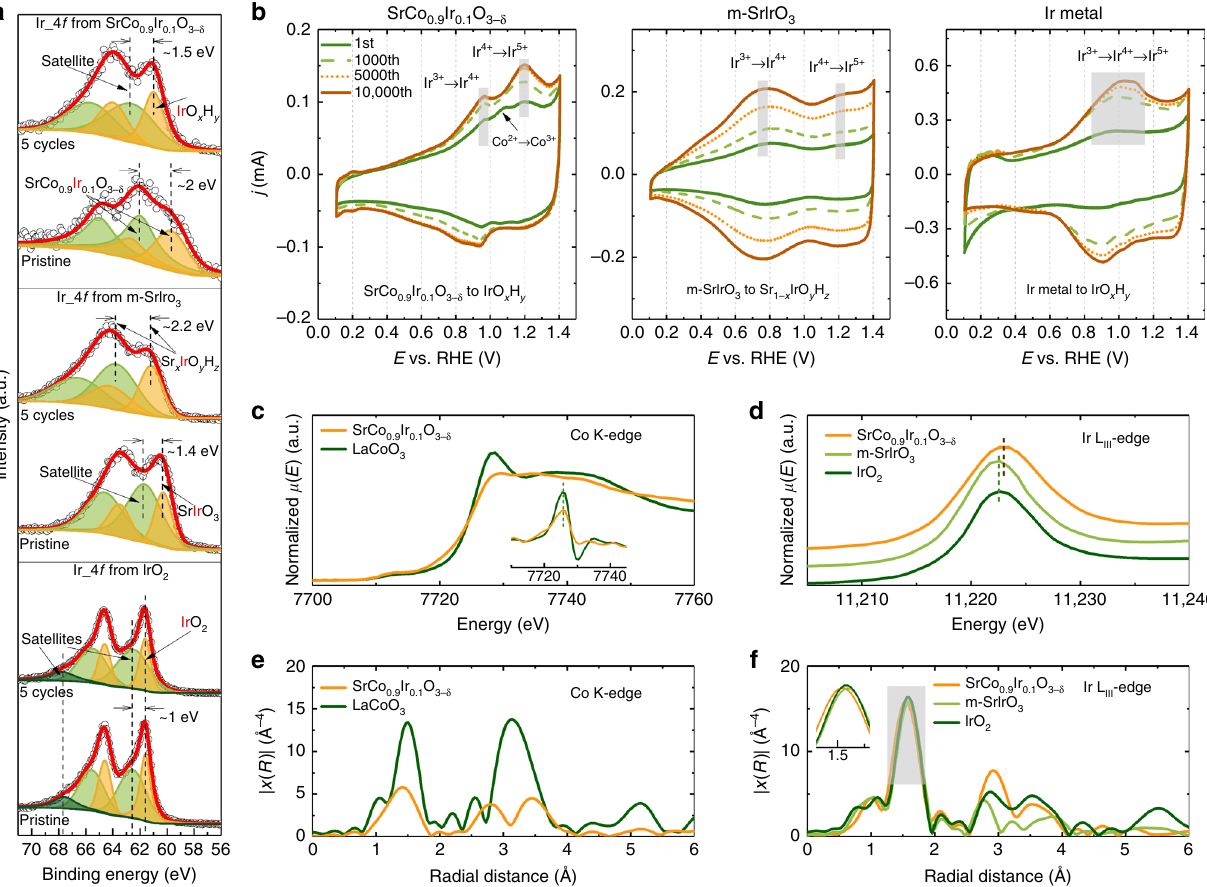
Fig. 3 Evaluation of the formed IrO x phase(s) and SrCo 0.9 Ir 0.1 O 3 − δ bulk chemical states. a Ir_4 f X-ray photoelectron spectroscopy (XPS) for IrO 2 , m-SrIrO 3 , and SrCo 0.9 Ir 0.1 O 3 − δ before and after the electrochemical tests. b The cyclic voltammetry (CV) curves recorded at the 1st, 1000th, 5000th, and 10,000th cycles for SrCo 0.9 Ir 0.1 O 3 − δ , m-SrIrO 3 , and Ir metal in a 0.1 M HClO 4 electrolyte. The cycles presented are collected at a scan rate of 100 mV s − 1 . For the intermediate cycles, a scan rate of 1 V s − 1 is applied. c X-ray absorption near edge structure (XANES) and 1st derivative XANES spectra (inset) of LaCoO 3 and SrCo 0.9 Ir 0.1 O 3 − δ measured at Co K-edge. d XANES spectra of IrO 2 , m-SrIrO 3 , and SrCo 0.9 Ir 0.1 O 3 − δ measured at Ir L III -edge. e k 3 -weighted Co K-edge Extended X-Ray Absorption Fine Structure (EXAFS) spectra of